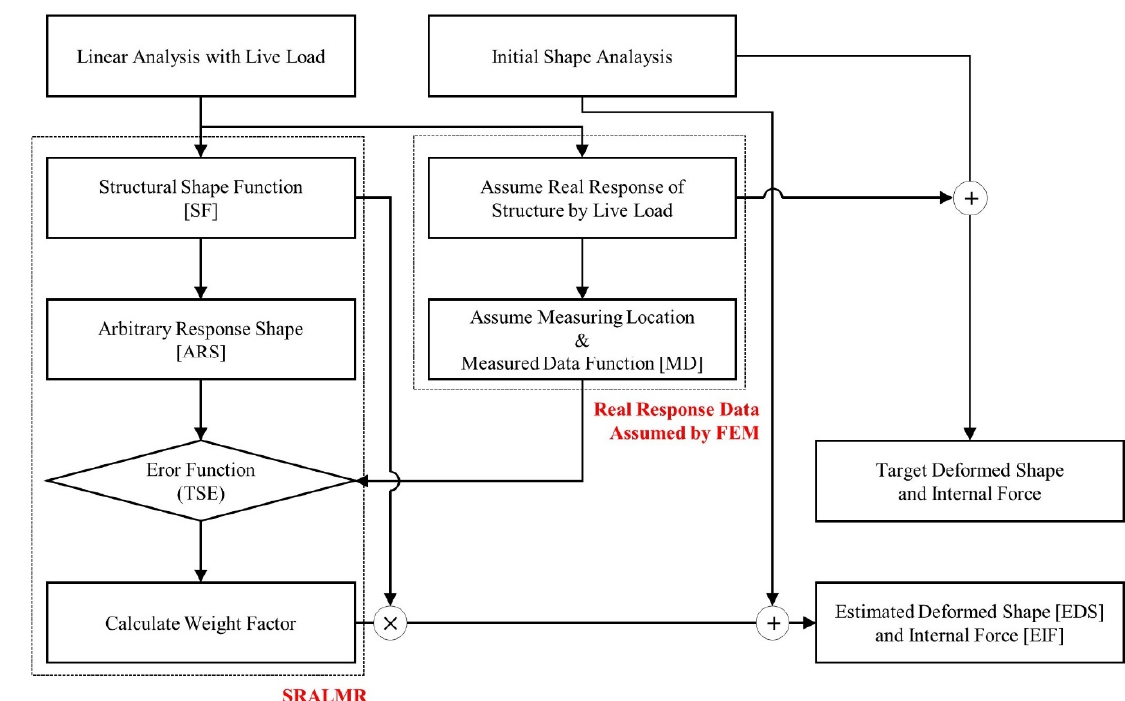
Figure 1. Validation analysis scheme of SRALMR for cable-stayed bridge.